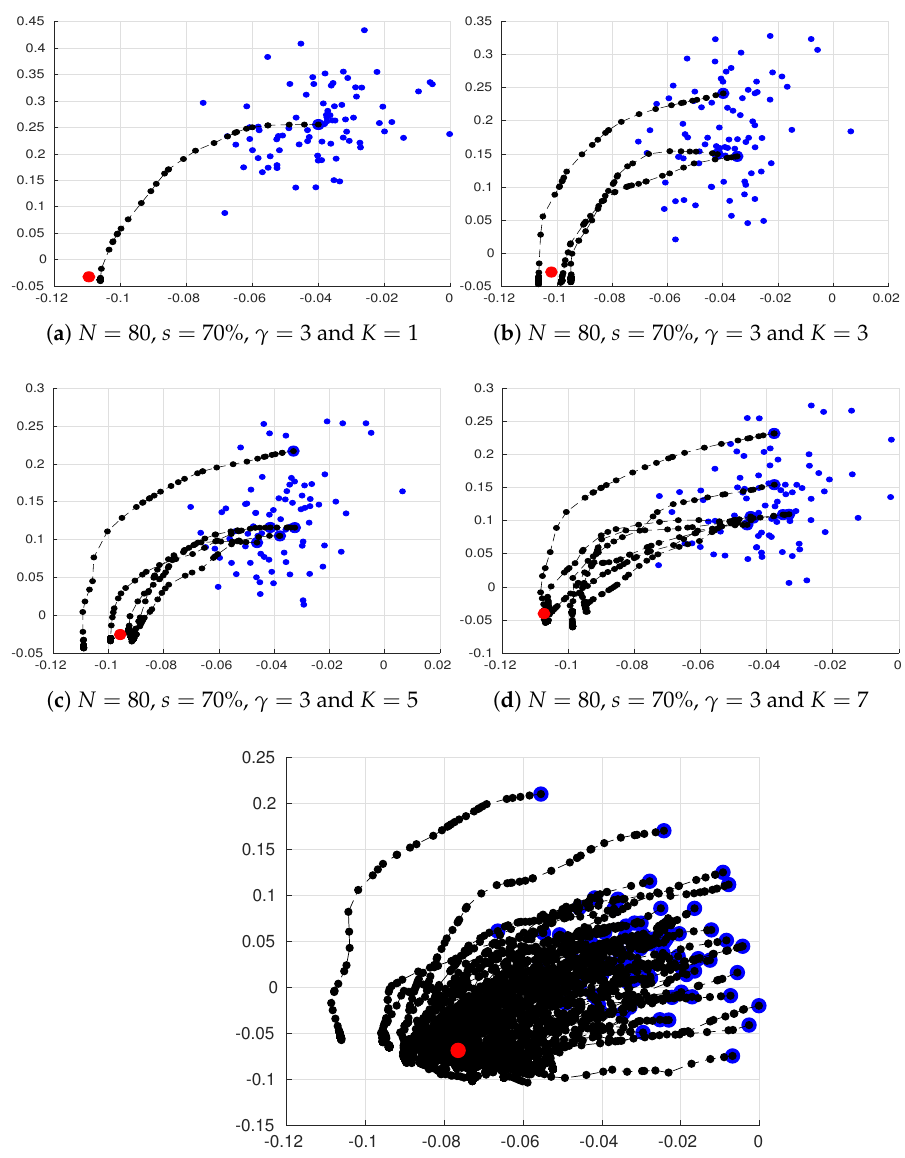
Figure 3. Two dimensional projections of the steps performed by the sampling method. Blue dots denote prior ensemble members x b [ e ] , large blue dots stand for centroids x b with black dots denote accepted states x ( u ) , and the red dot stands for the actual state of the system x ∗ . Even for K = N , the method is able to obtain reasonable estimates of the actual state of the system. The variance explained in such plots is larger than